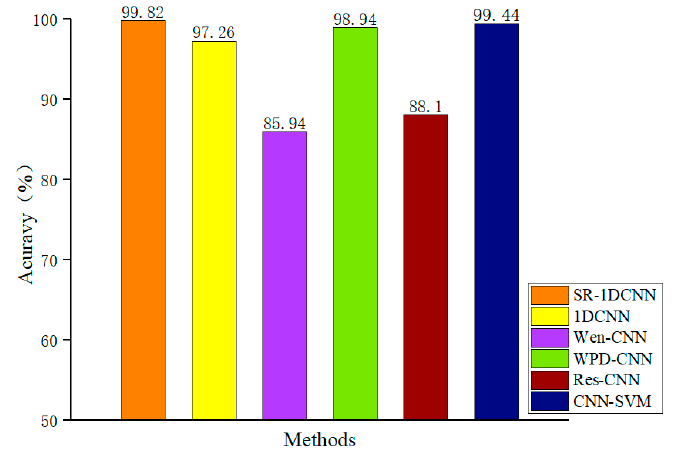
Figure 12. Comparison of different methods (test set of